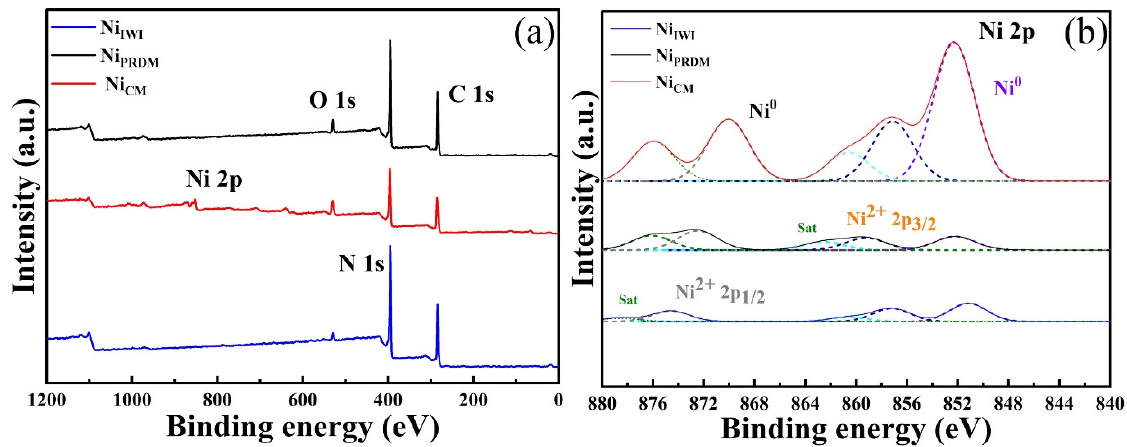
Figure 2. XPS profiles of the obtained samples for ( a ) survey and ( b ) Ni 2p scan.